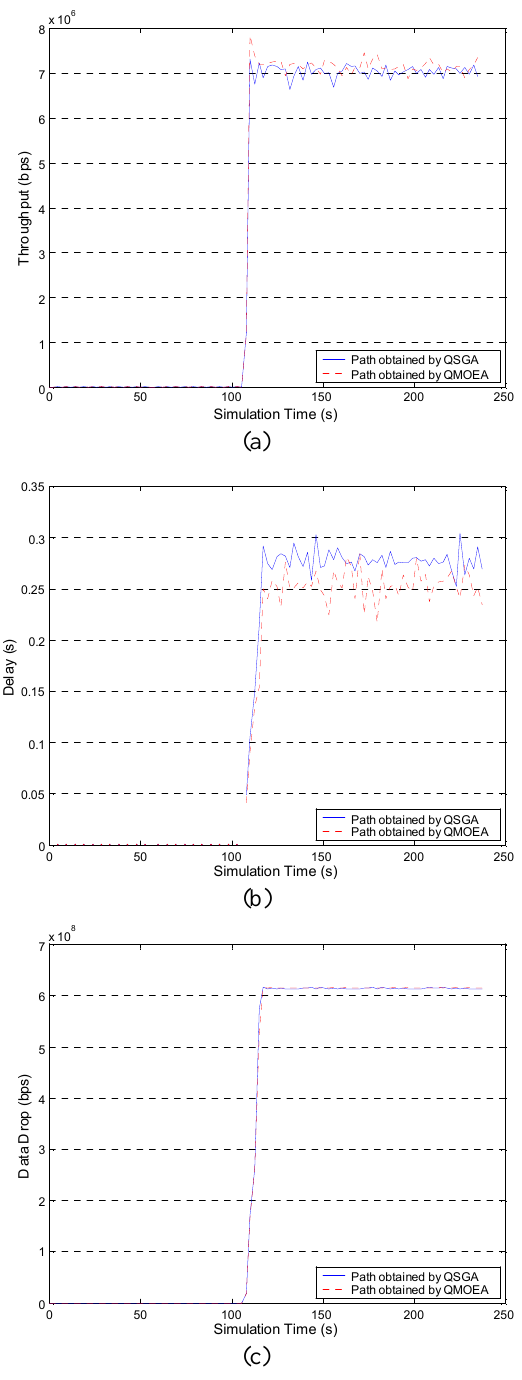
Fig. 10 Comparison of performancebetween two paths when MANET is running with Video Conferencing